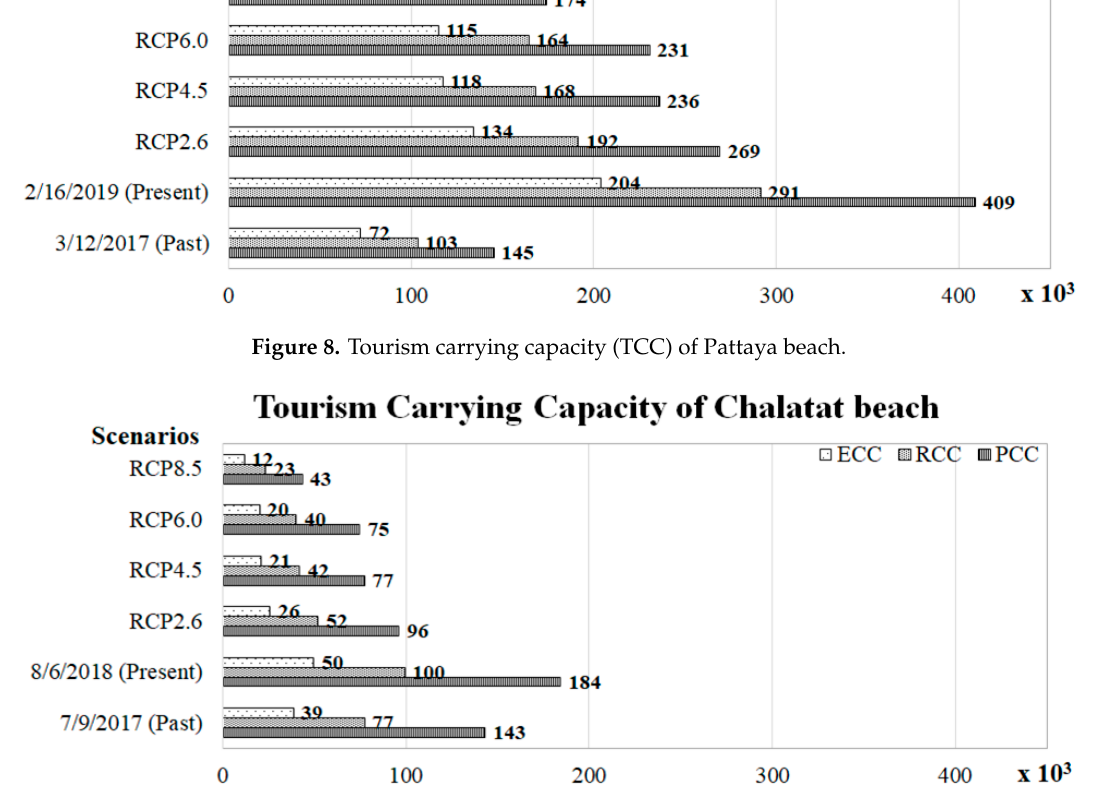
Figure 9. TCC of Chalatat beach.